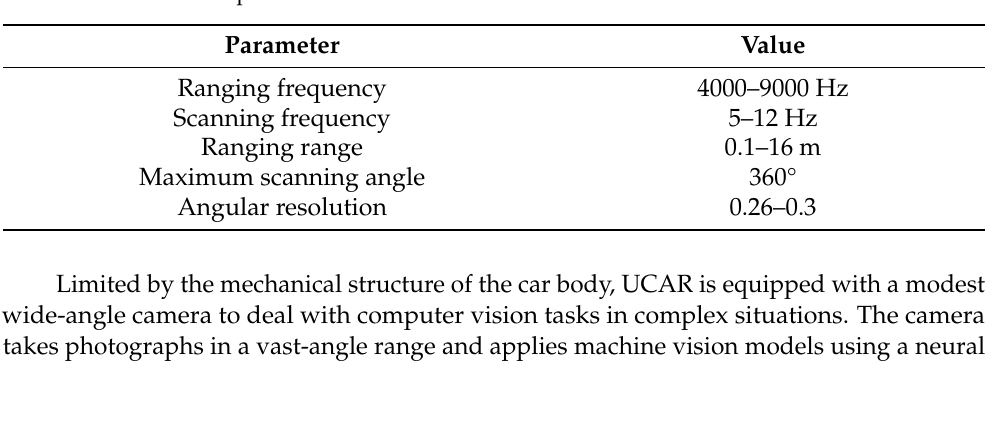
Table 2. Values of lidar